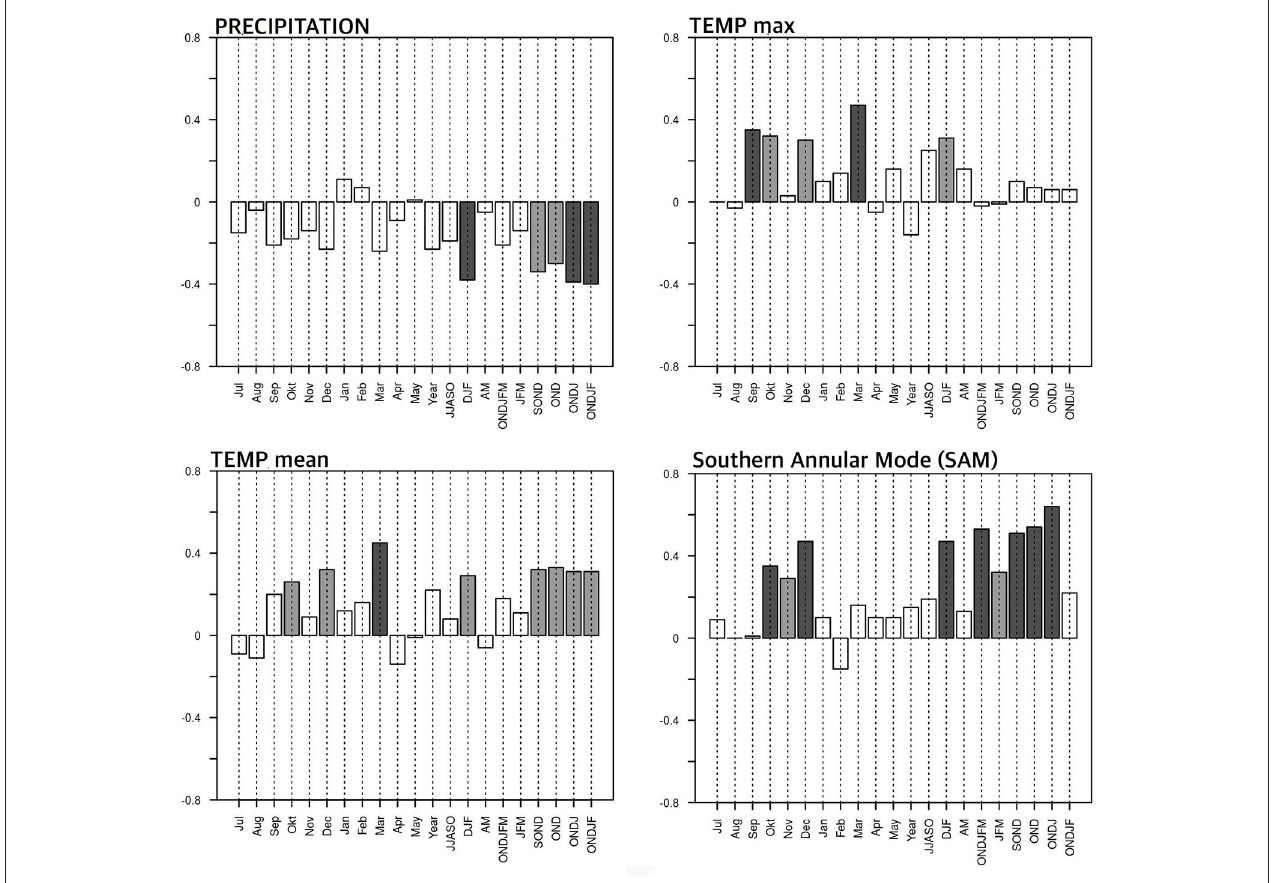
FIGURE 4 | Climate-Proxy-Relationships between the δ 18 O TRC time series and selected climate parameters of the climate station in El Calafate. In addition, results of calculations with the Southern Annular Mode (SAM) are shown. Light gray bars indicate correlations reaching the p < 0.05 level of significance, dark gray bars correlations exceeding the p < 0.01 level of